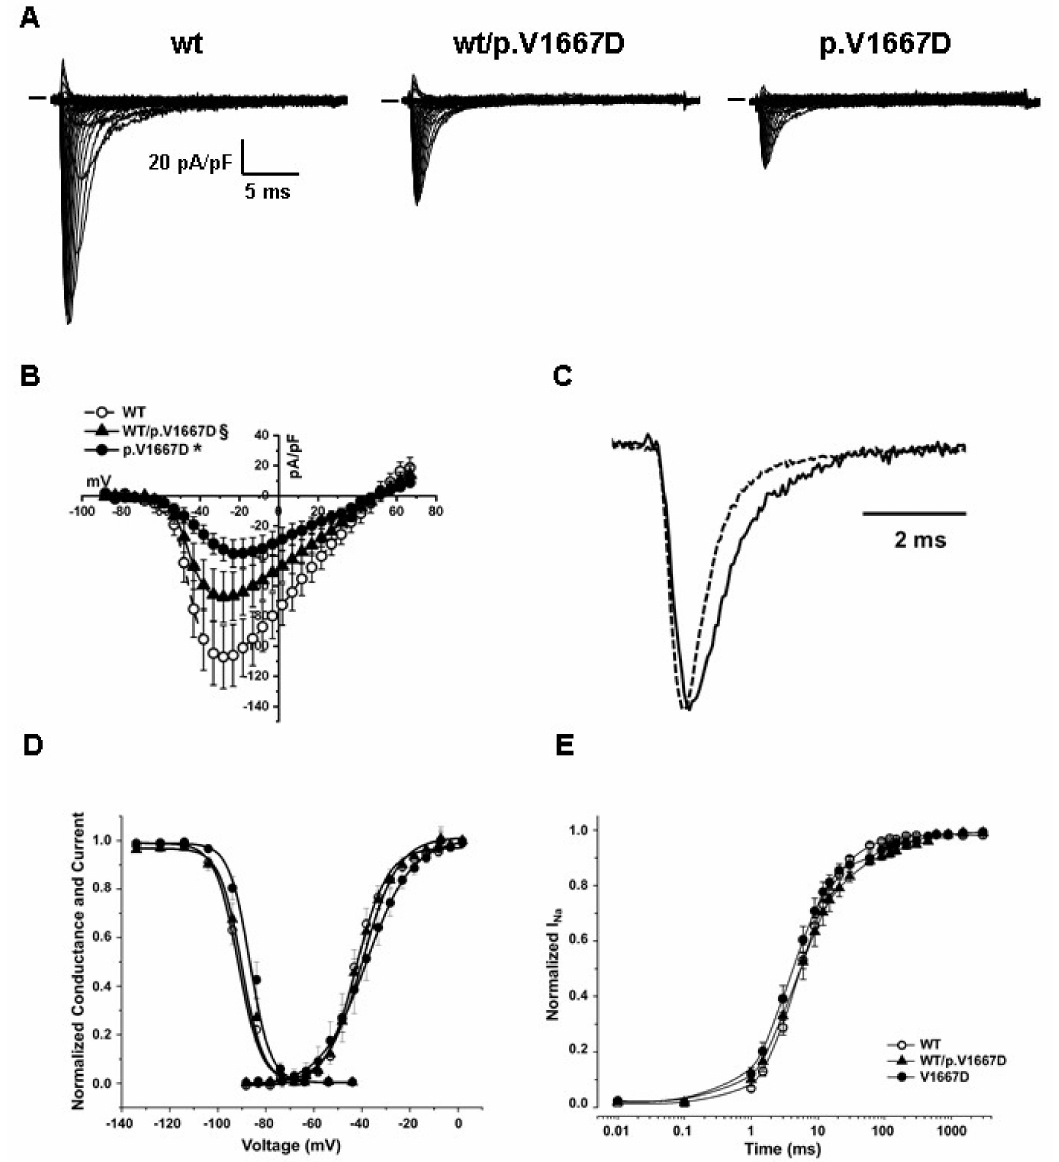
Figure 5. Functional characterization of the p.V1667D variant in HEK293 cells. ( A ) Typical families of current traces recorded from HEK cells expressing WT, WT/p.V1667D, and p.V1667D Nav1.5 channel. The current amplitude measured in 40 mM extracellular Na + was normalized by the cell capacitance. ( B ) Averaged current-voltage relationship (empty circles for WT, filled circles for p.V1667D and triangles for WT/p.V1667D). ( C ) Comparison of normalized WT (dashed line) or p.V1667D (solid line) Nav1.5 current elicited by a depolarizing step @-20 mV showing the impairment in the kinetics of the activation and fast inactivation process. ( D ) Steady state activation and availability curve. ( E ) Recovery from the inactivation. Statistics and numbers of cells tested are reported in Table